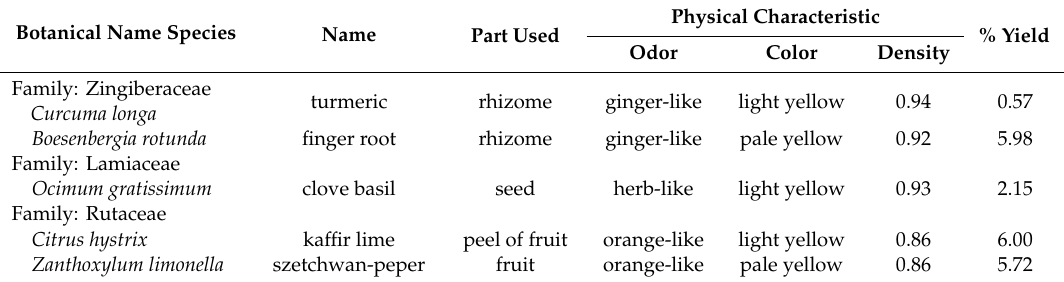
Table 2. Physical characteristics and percentage yield of essential oils